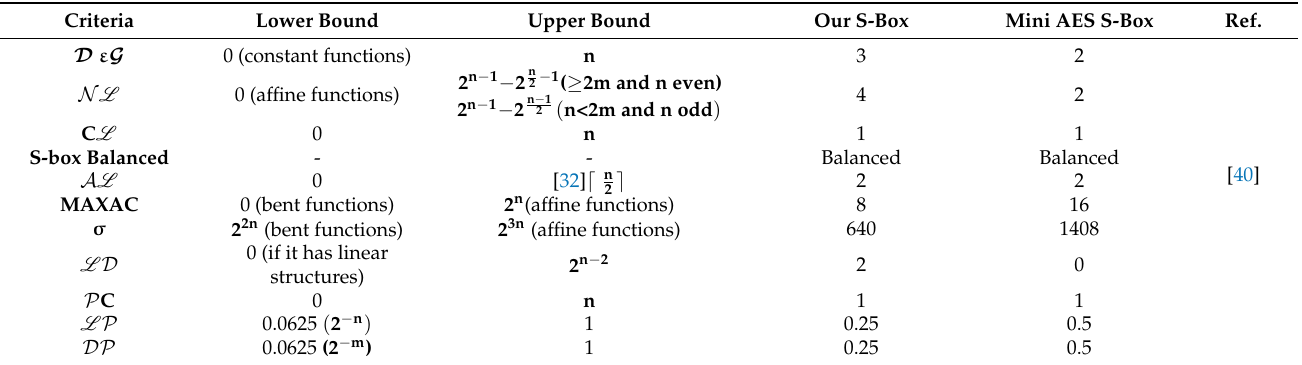
Table 2. Comparison with Respect to Cryptographic Criteria of Sbox_Nibble Layer for our design Approach and Mini